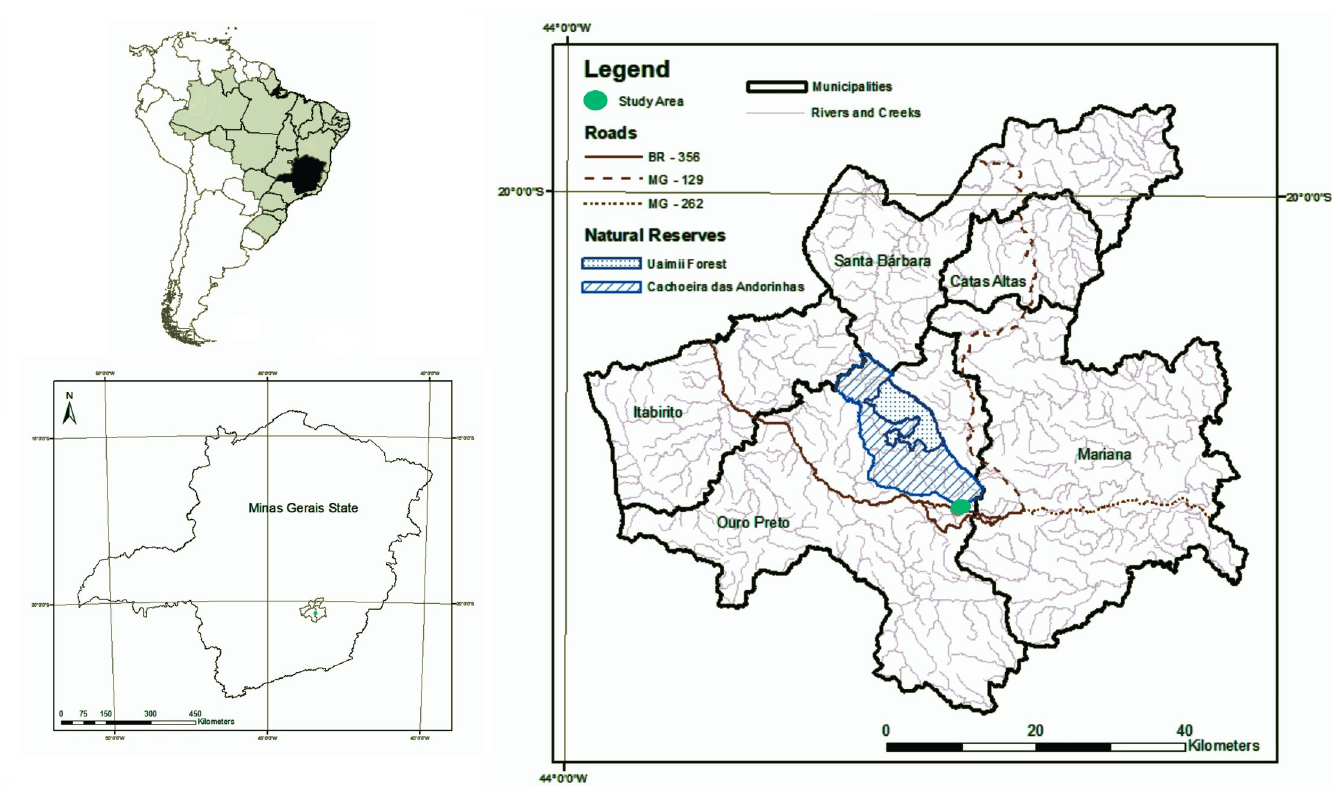
Fig 1. Location of the study area in the municipality of Ouro Preto, Minas Gerais State, Brazil.